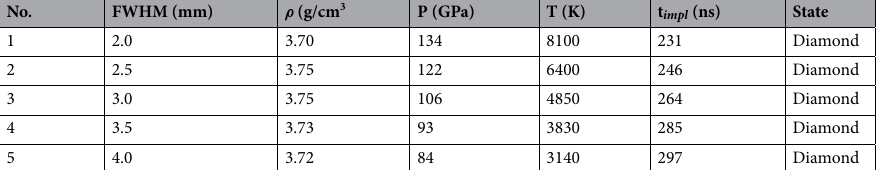
Table 2. Achieved physical conditions in compressed carbon using bunch intensity = 3 × 10 11 uranium ions, bunch length = 200 ns, particle energy = 2 GeV/u, initial sample radius, R si = 400 μm, sample mass = 11.3 mg/ cm.